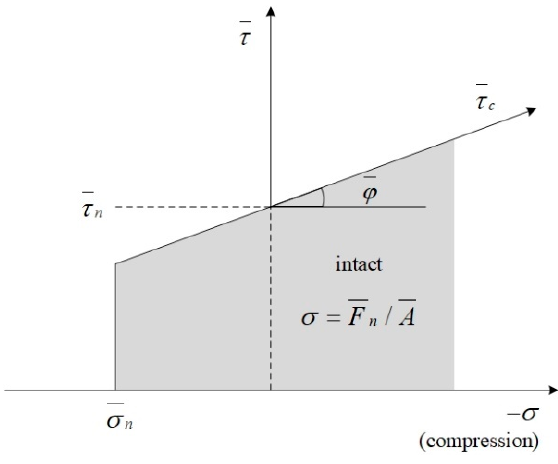
Figure 14. Failure envelope for the parallel-bond.